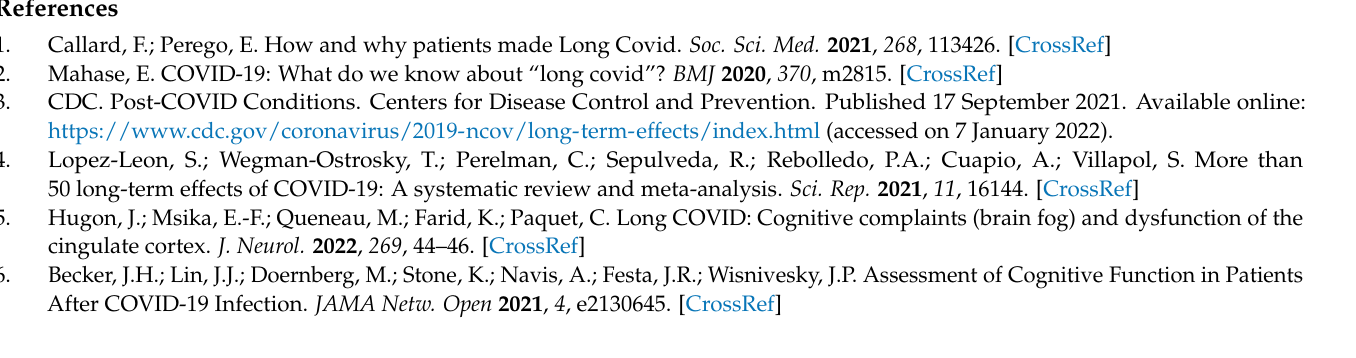
COVID − Group. Table S2: Descriptive Statistics from the COVID+ Group. Table S3: Edge Weight Estimates and Bootstrap Results for All Edges Included in the COVID − Network. Table S4: Edge Weight Estimates and Bootstrap Results for All Edges Included in the COVID+ Network. Table S5: Edge Weight Comparisons from the Network Comparison